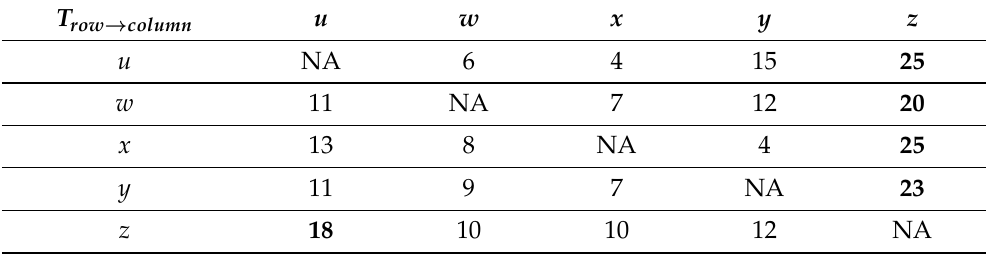
Table 6. Sum of cases where the mean value of the Transfer Entropy coefficient in a row for a given variables pair is the highest—1st variant (50 subdatasets).